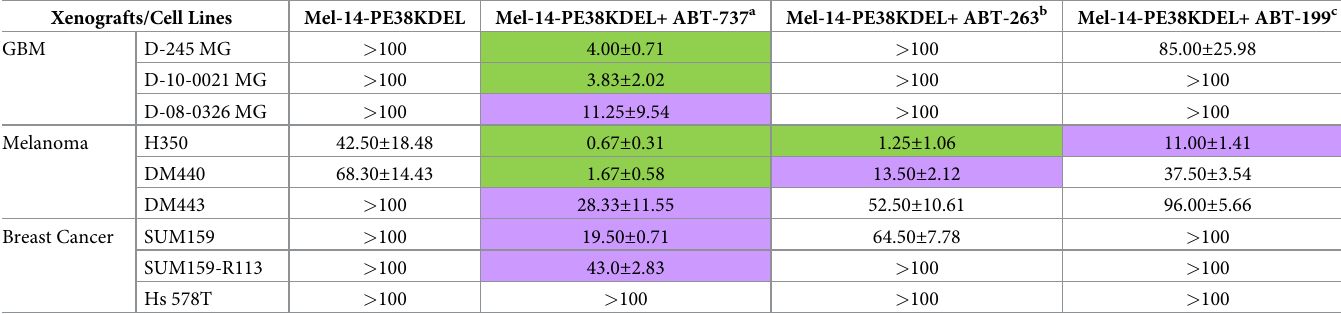
Table 1. In vitro cytotoxicity (IC 50 ng/ml) of ABT-737, ABT-263, or ABT-199 in combination with Mel-14-PE38KDEL immunotoxin. Xenografts/Cell Lines